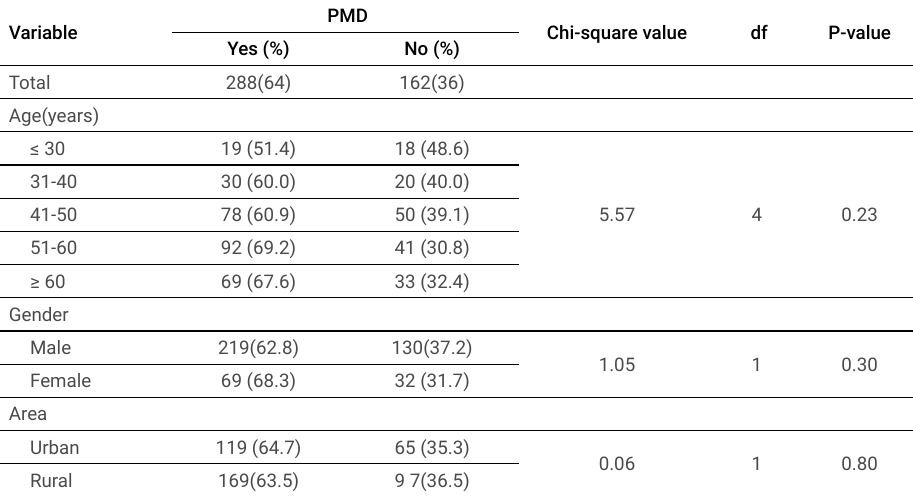
Table 1. Distribution of subjects according to Age, Gender, Area of residence and PMD.